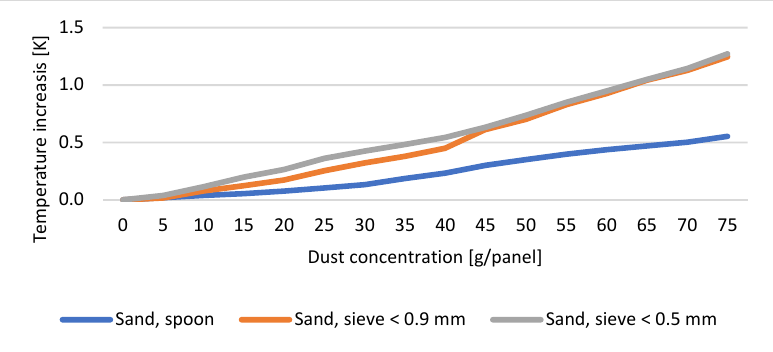
Figure 14. The temperature increase as a function of the sand concentration.